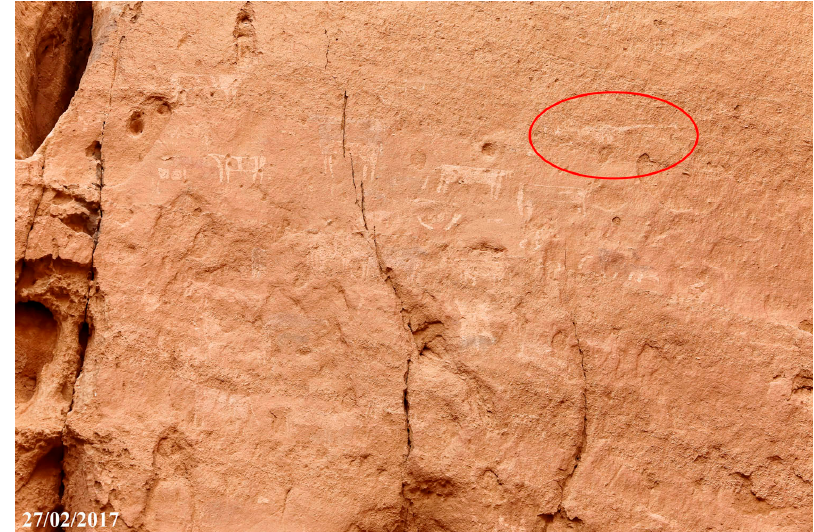
Figure 12. White remains of cattle figures forming a large cluster of paintings at P7 (Photo: Alessandro Menardi Noguera). On the upper right, one isolated schematic giraffe is present (red ellipse).